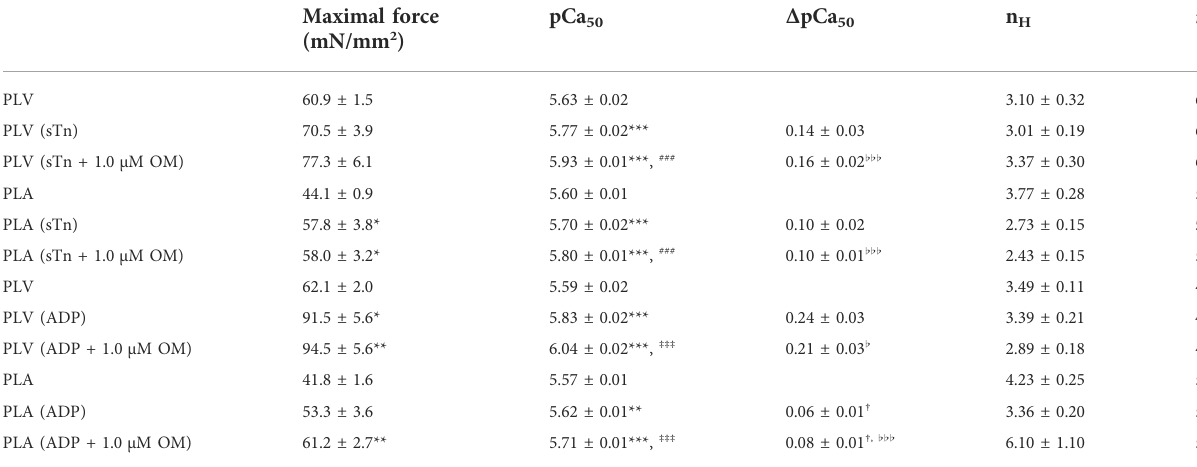
TABLE 3 Summary of the effects of OM on maximal force, Ca 2+ sensitivity and n H in PLV and PLA under enhanced activation condition.